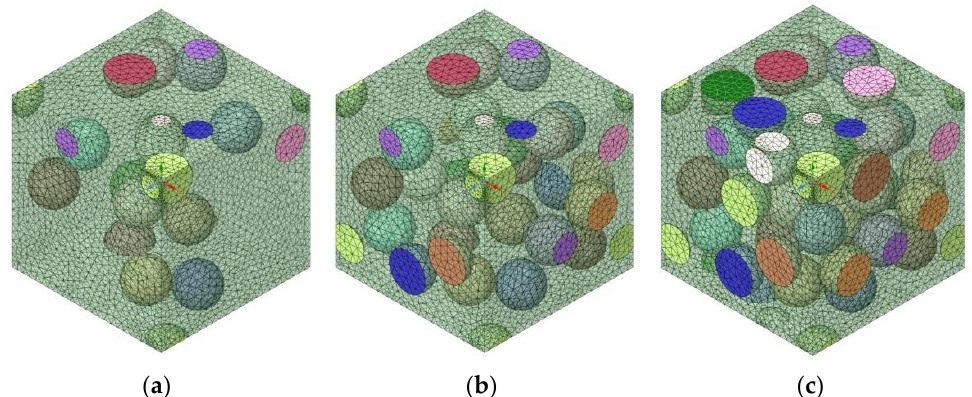
Figure 2. Mesh modeling with different ultra-high molecular weight polyethylene (UHMWPE) volume fractions: ( a ) 10%, ( b ) 20%, and ( c ) 30%. Table 1. Properties of polypropylene (PP) and ultra-high molecular weight polyethylene (UHMWPE). No.